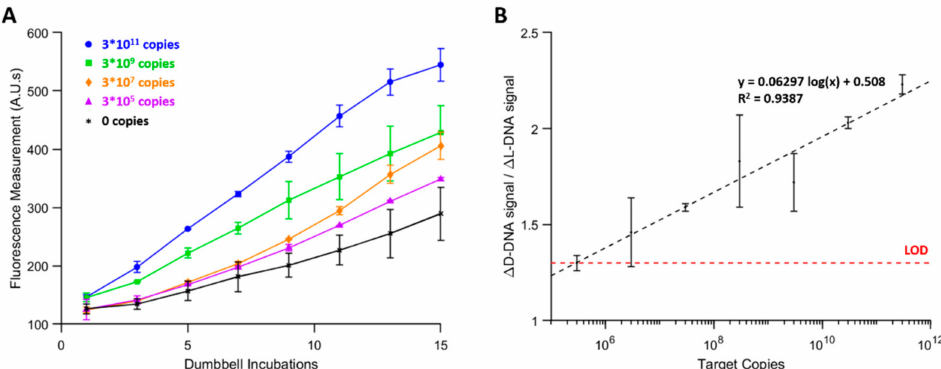
Figure 6. ( A ) D-DNA amplification curves for autoPiLOT trials for a range of target copy numbers. ( B ) Signal ratio, or the ratio of change in D-DNA signal to change in L-DNA signal after 15 dumbbell incubations, is plotted (black dots) as a function of target copy number. A logarithmic line best fit is overlaid as a black dashed line. The red dashed line represents the threshold signal ratio used to determine the limit of